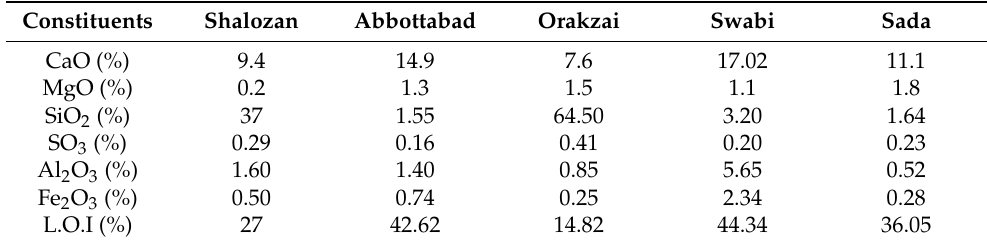
Table 6. Chemical composition of used